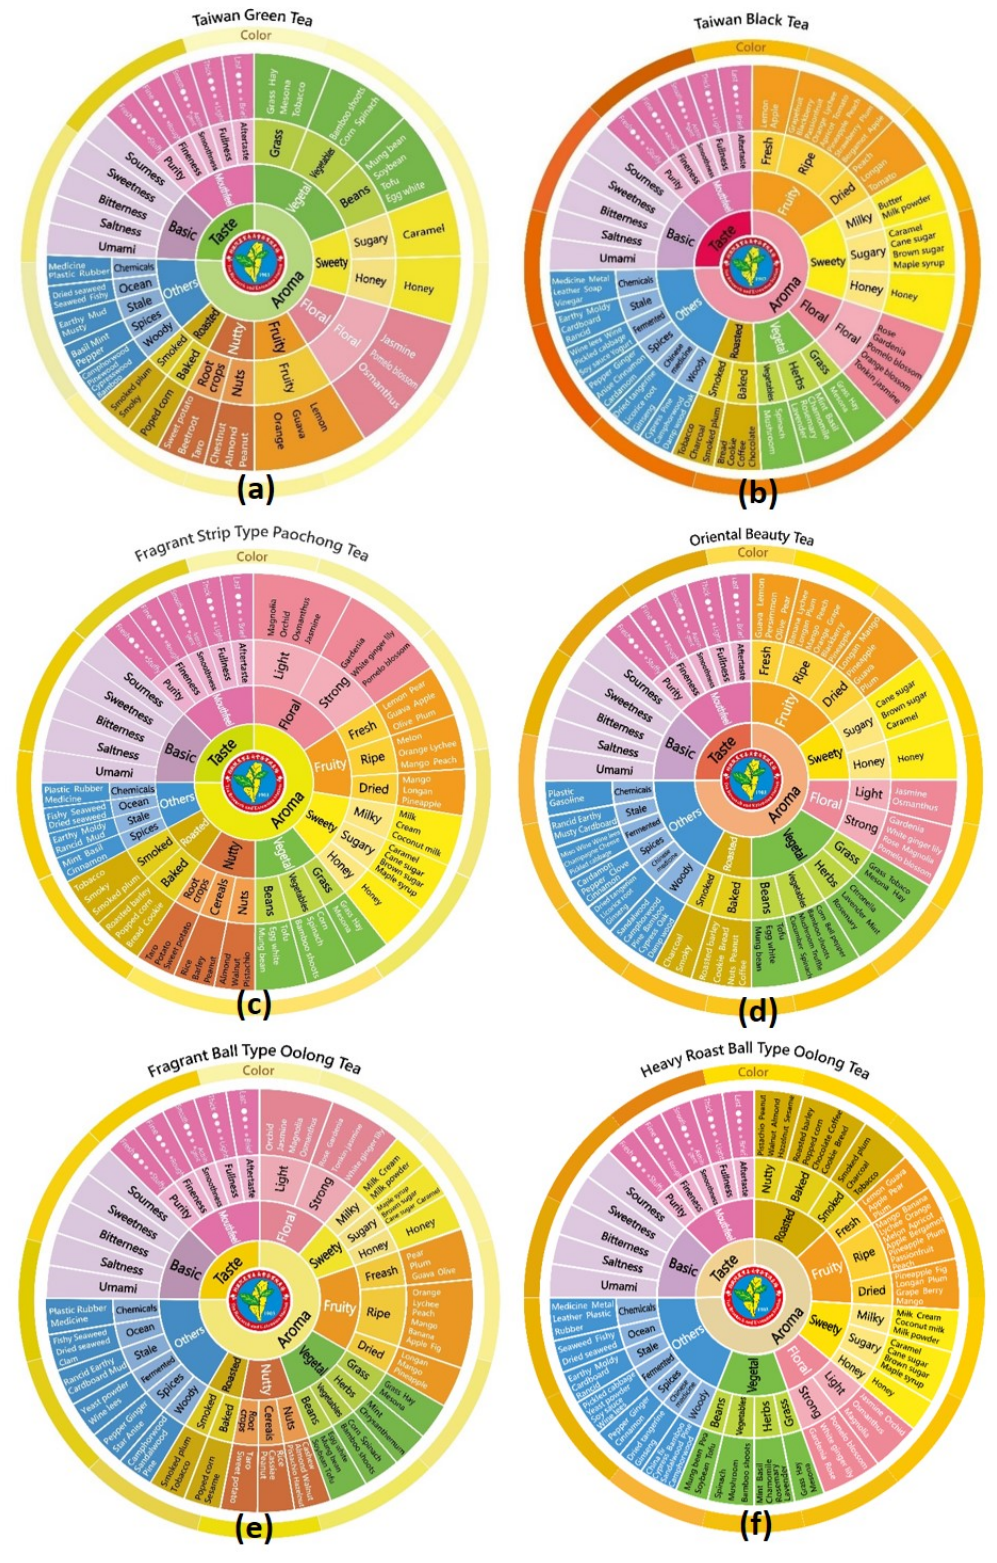
Figure 4. The sensory wheels for ( a ) Taiwan green tea, ( b ) Taiwan black tea, ( c ) fragrant strip-type Paochong tea, ( d ) Oriental Beauty tea, ( e ) fragrant ball-type Oolong tea, and ( f ) heavy roast ball-type Oolong tea. The high-resolution graphs are reproduced with copyright permission from the Tea Research and Extension Station (TRES), Taiwan (https://www.tres.gov.tw/ws.php?id=3744, accessed on 15 April 2020).